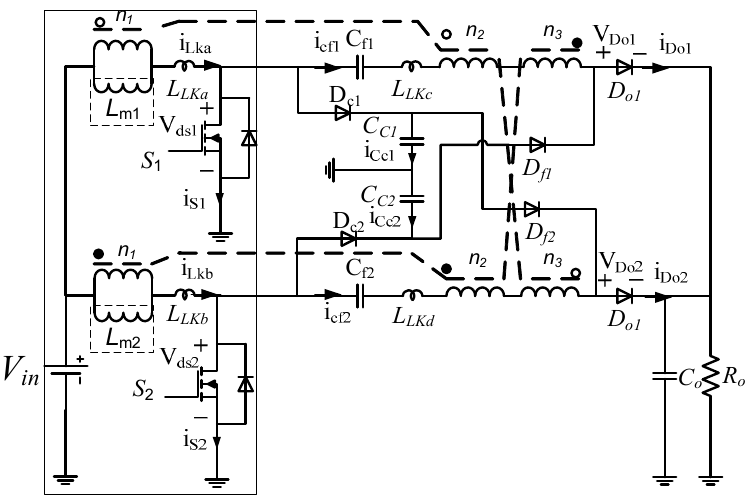
Figure 2. Equivalent circuit of the interleaved high step-up current sharing converter.